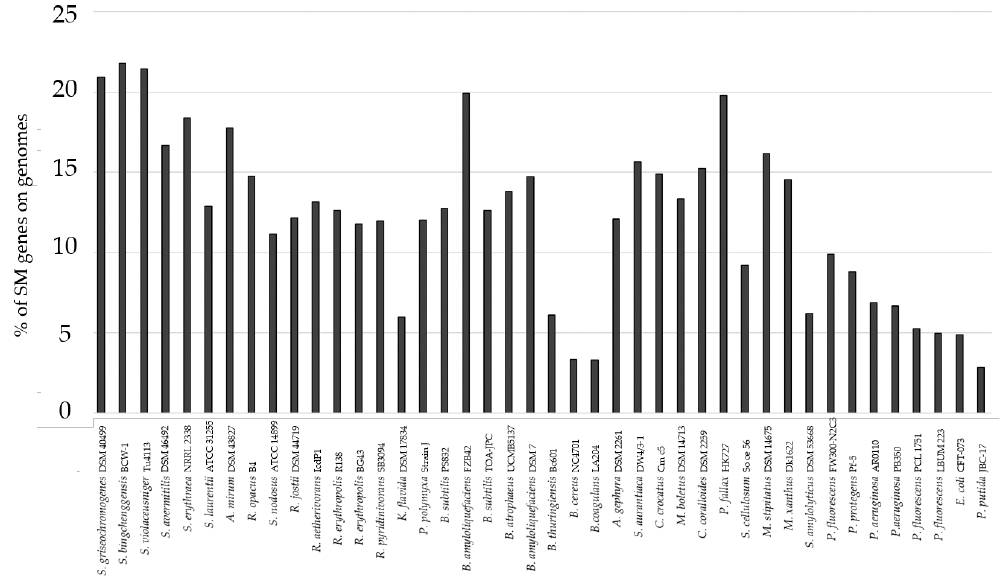
Figure 1. Percentage of genes relating to the entire number of mapped genes in the genome of the selected bacteria. The genome mining approach was carried out with antiSMASH [9]. A total of 42 bacteria were investigated for their potential to harbor silent biosynthetic gene clusters (BGCs) in their genome. The complete list of bacteria is presented in the supplement (Table S1). SM, secondary metabolite.